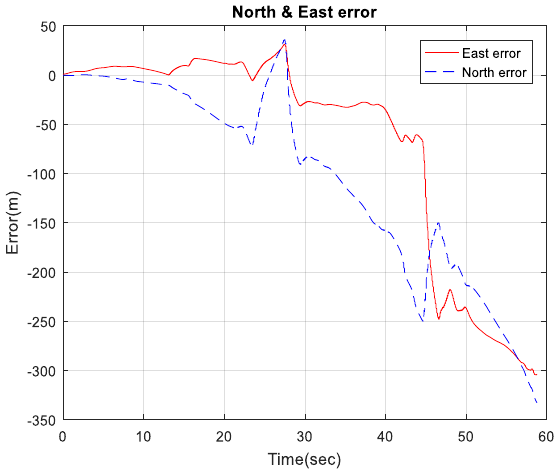
Figure 12. Errors in north and east directions of the INS - Standalone system during GNSS signal outage for 60 Secs.